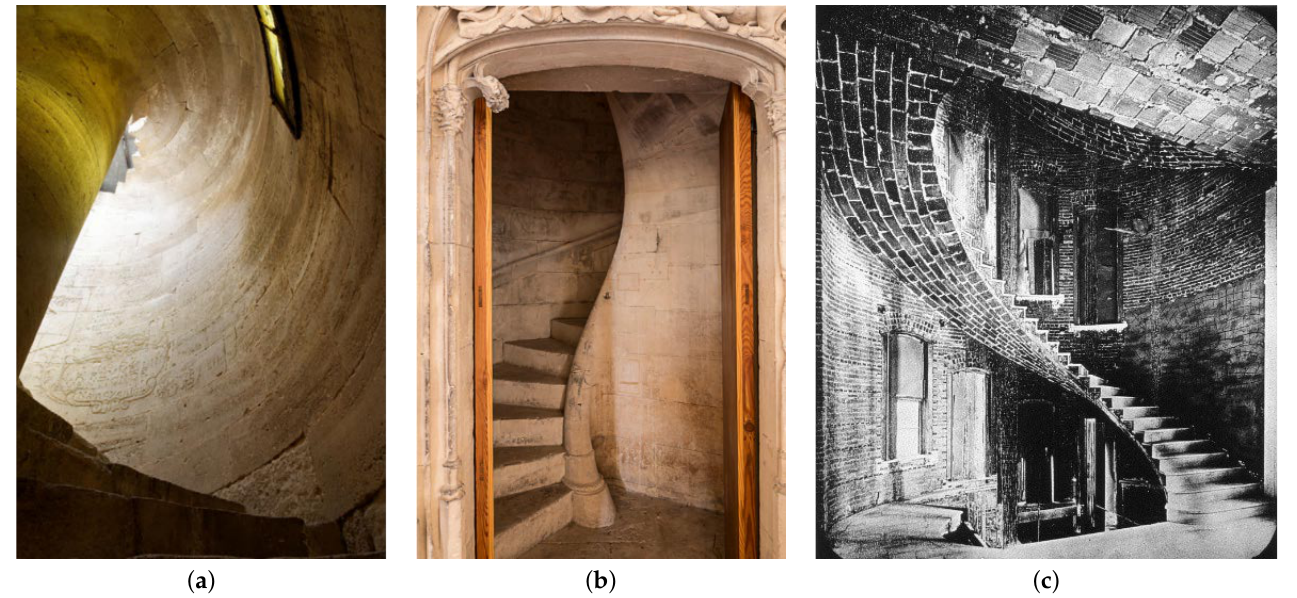
Figure 1. ( a ) Interior view of the vis de Saint Gilles in Languedoc (France). Notice the inscriptions made by 17th-century stonemasons on the walls of its perimeter box. ( b ) The spiral staircase of the northwest tower of the Lonja of Palma de Mallorca (Spain). ( c ) Guastavino helicoidal tile stair in the First National Bank of Peterson, New York City, ca.1890 (Guastavino archive, Columbia University)